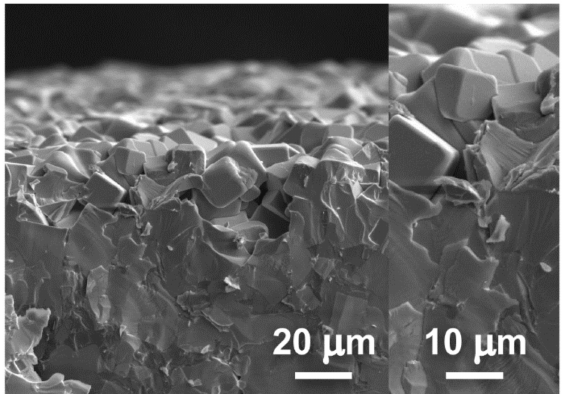
Figure 7. Microstructure of a cross section (fracture) of the NBT-Eu ceramic sample thermally treated at 1280 ◦ C. It is seen that, beneath the treated surface, the microstructure is dense.